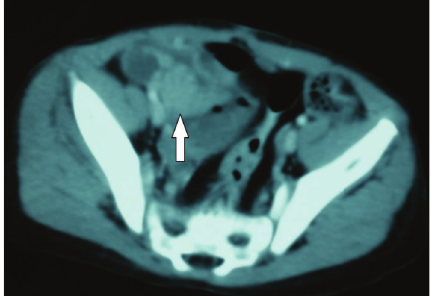
Figure 2: Preoperative axial contrast-enhanced CT scan showing a mass growing next to the right ovary (white